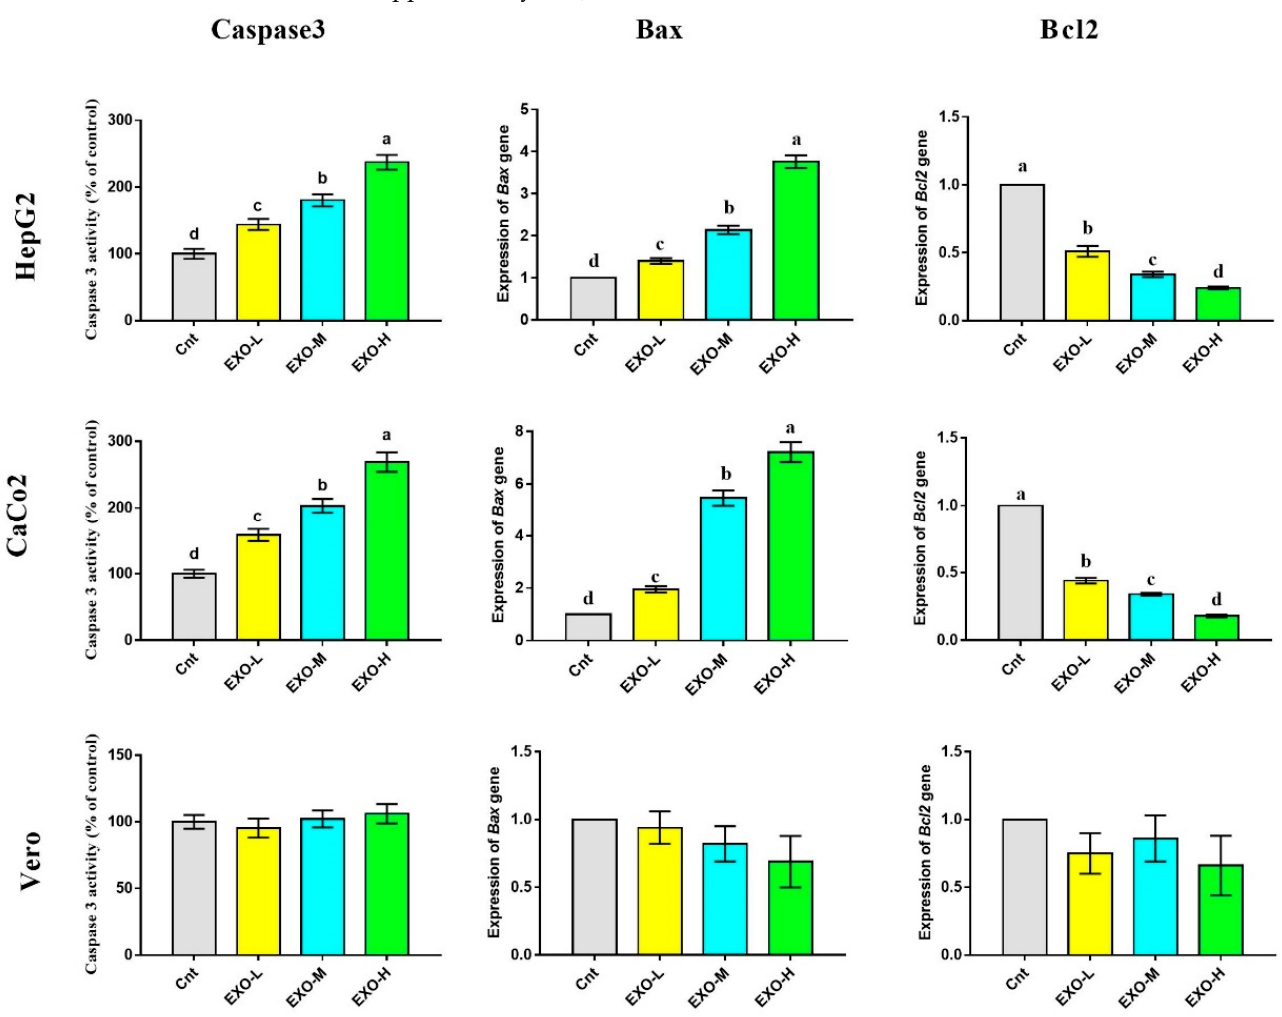
Figure 5. Effect of CM-EXOs on activities of caspase 3 and expression of Bax and Bcl2 as detected by ELISA and qPCR, respectively. Values are expressed as fold change mean ± SEM ( n = 3/group). Columns with different letters are significantly different at p < 0.05. All groups were compared to each other. Cnt, control cells; EXO-L, cells treated with low dose of EXOs; EXO-M, cells treated with medium dose of EXOs, and EXO-H, cells treated with high dose of EXOs.